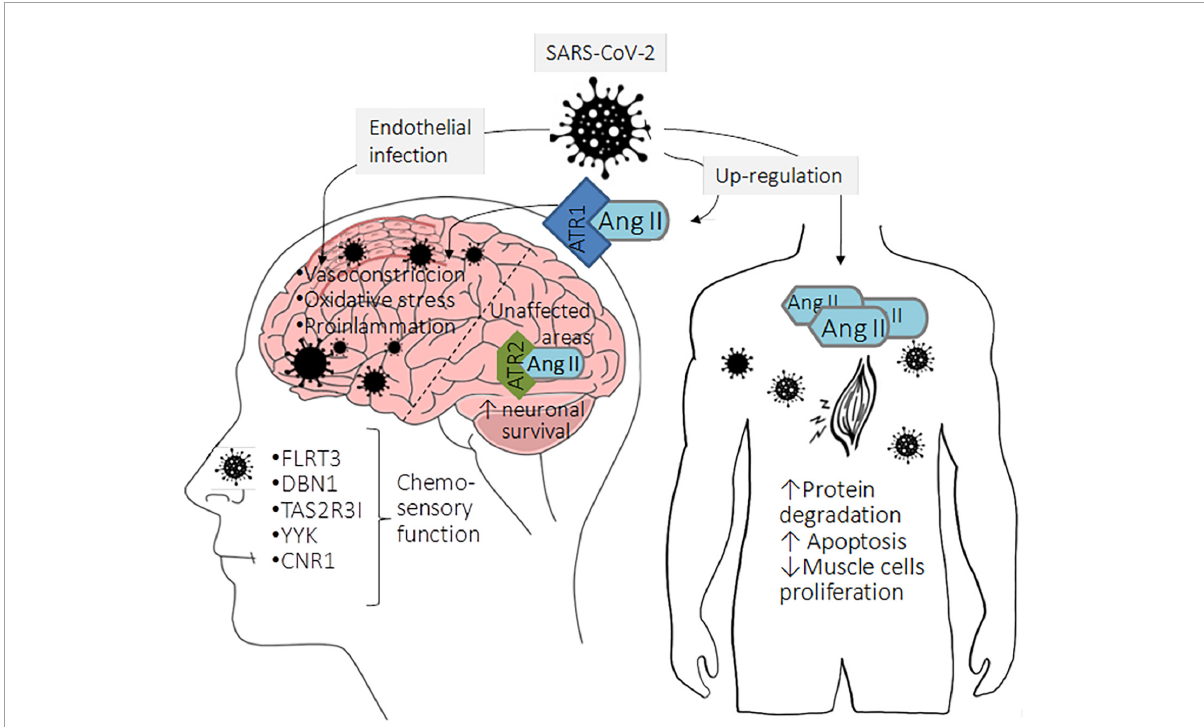
FIGURE2 Neurological symptoms as consequence of classical RAS upregulation in COVID-19 patients. The lack of Ang II processing by ACE2 and its subsequent binding to AT1R can cause a local pro-inflammatory state that activates neuronal programmed cell death and the consequent dopaminergic neuronal loss leading to cognitive problems. Accumulating evidence indicates that brain areas unaffected by the virus show a low AT1R expression accompanied by high AT2R expression. Then, Ang II can bind to AT2R with high affinity, triggering protective mechanisms such as neuronal survival. Although previous information suggested that peripheral sensory neurons did not express ACE2, recent evidence indicates that these cells express low ACE2 levels, which may favor viral entry and infection. Subsequently, the infection leads to altered expression of genes associated with chemosensory functions, such as the olfactory neuronal markers, fibronectin leucine-rich transmembrane protein (FLRT3), drebrin 1 (DBN1), taste 2 receptor member 31 (TAS2R31), chemosensory regulatory factors Yin Yang 1 (YY1), and cannabinoid receptor 1 (CNR1). Moreover, the musculoskeletal symptoms in COVID-19 patients could be related to Ang II upregulation that orchestrates protein degradation and skeletal muscle cell apoptosis, possibly leading to loss of skeletal muscle